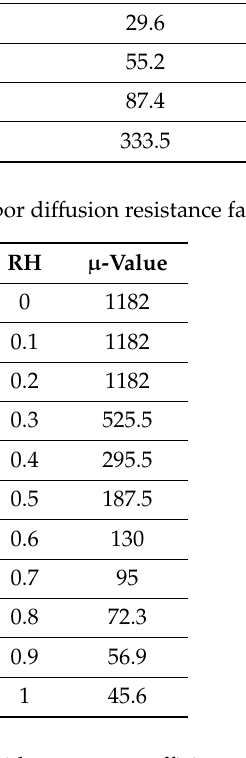
Table A19. Liquid transport coe ffi cient—Design.